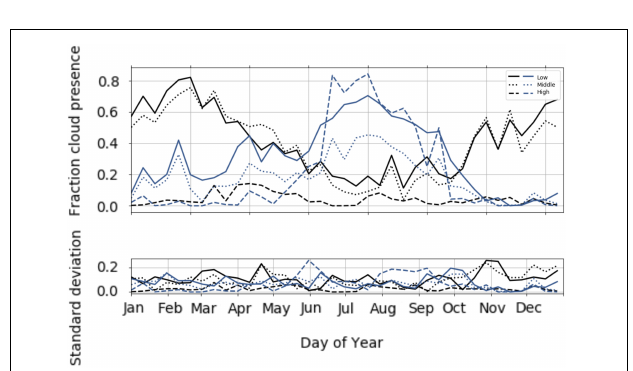
FIGURE 8 | Fraction of glacierized cells which are covered by high- ( > 6 km a.s.l) middle- (2–6 km a.s.l) and low ( < 2 km a.s.l) clouds (upper panel). The lower panel indicates the standard deviation of the average values. Altitudes are indicated as altitude above the surface. Three-years averaged for Langtang (blue) and Shimshal (black).